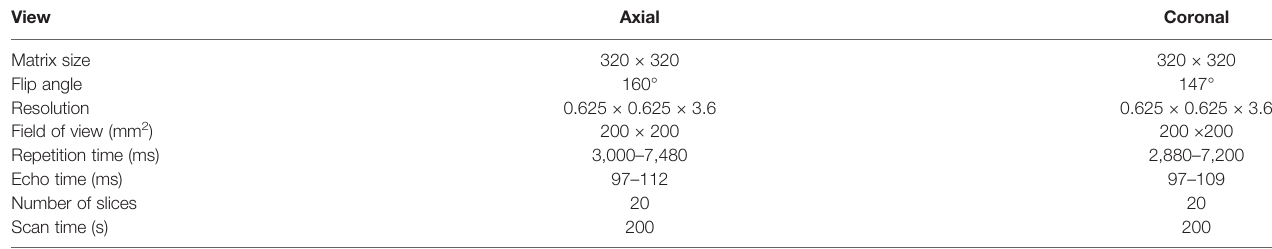
ms, millisecond; s, second; mm,